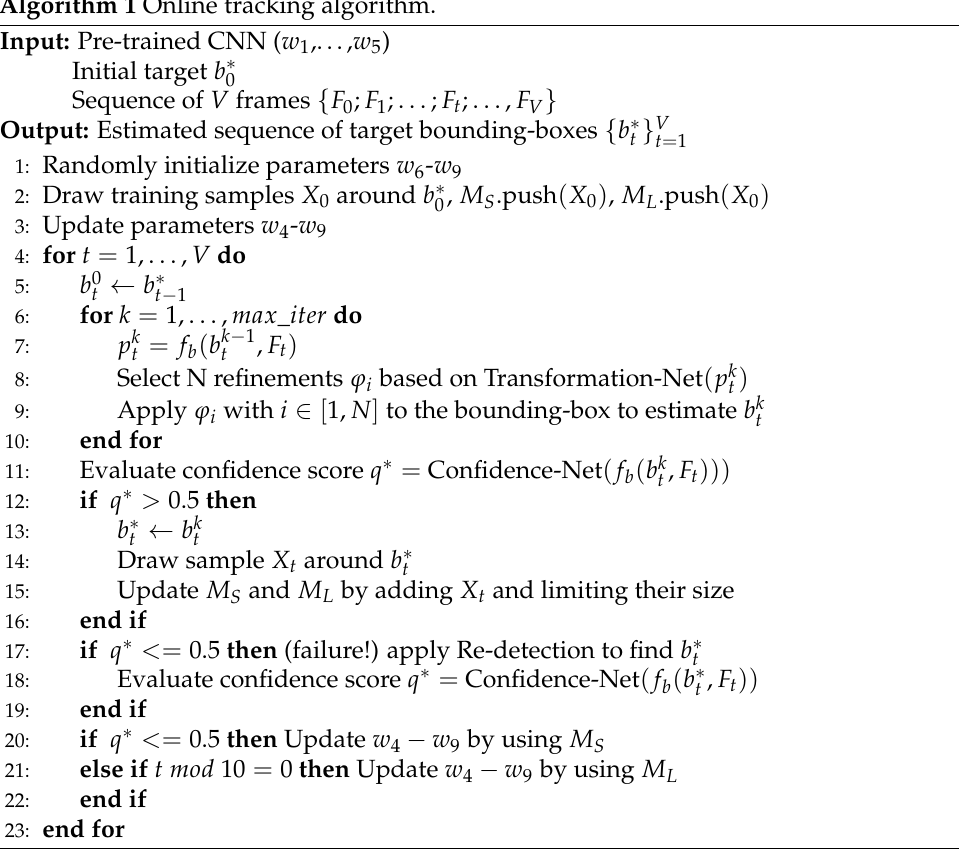
Algorithm 1 Online tracking